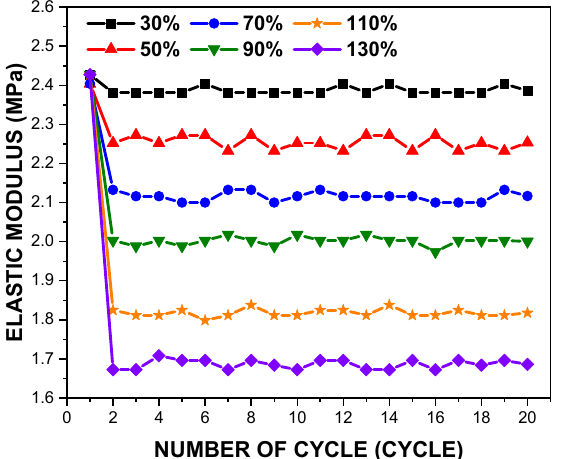
Figure 7. Deviations in elastic modulus of the PDMS film with a thickness of 150 μ m at the elevated tensile loading cycles.